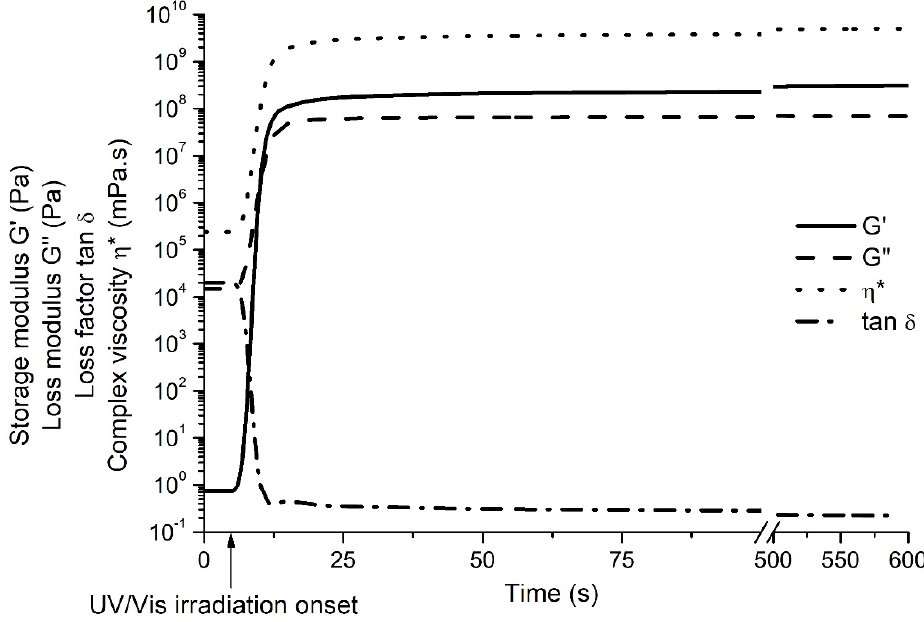
Figure 3. Dependencies of the rheological characteristics of the resin VS on the irradiation time.